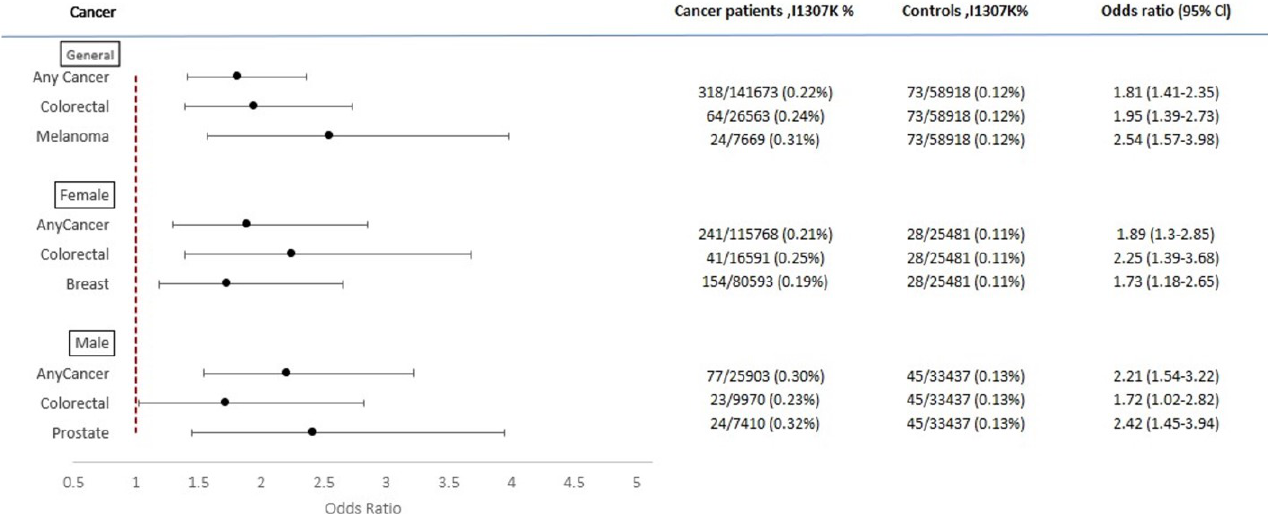
Figure 3. Forest plot representing the OR for different types of cancer according to the APC I1307K variant status in NAW.